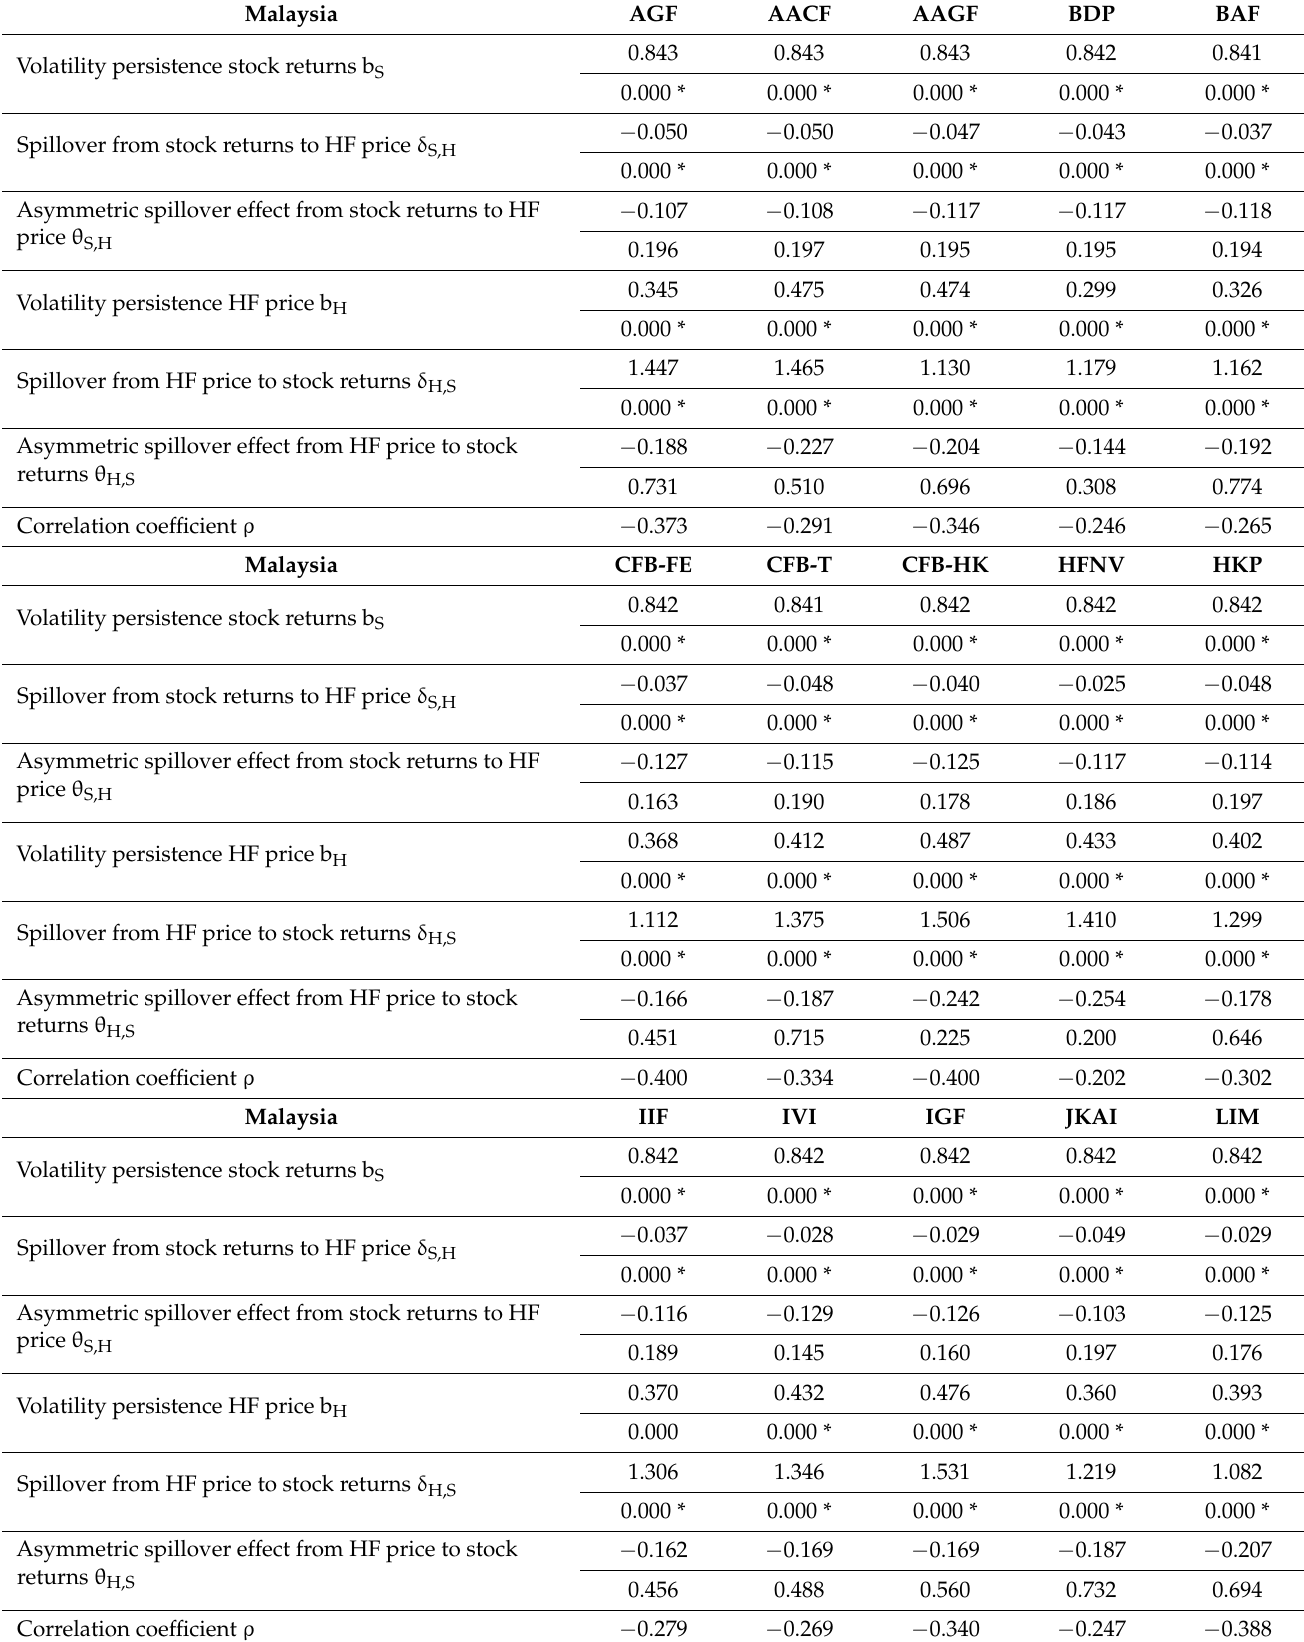
Table 12. Volatility spillover between the Malaysian Stock Market (FBMKLCI) and Hedge Fund